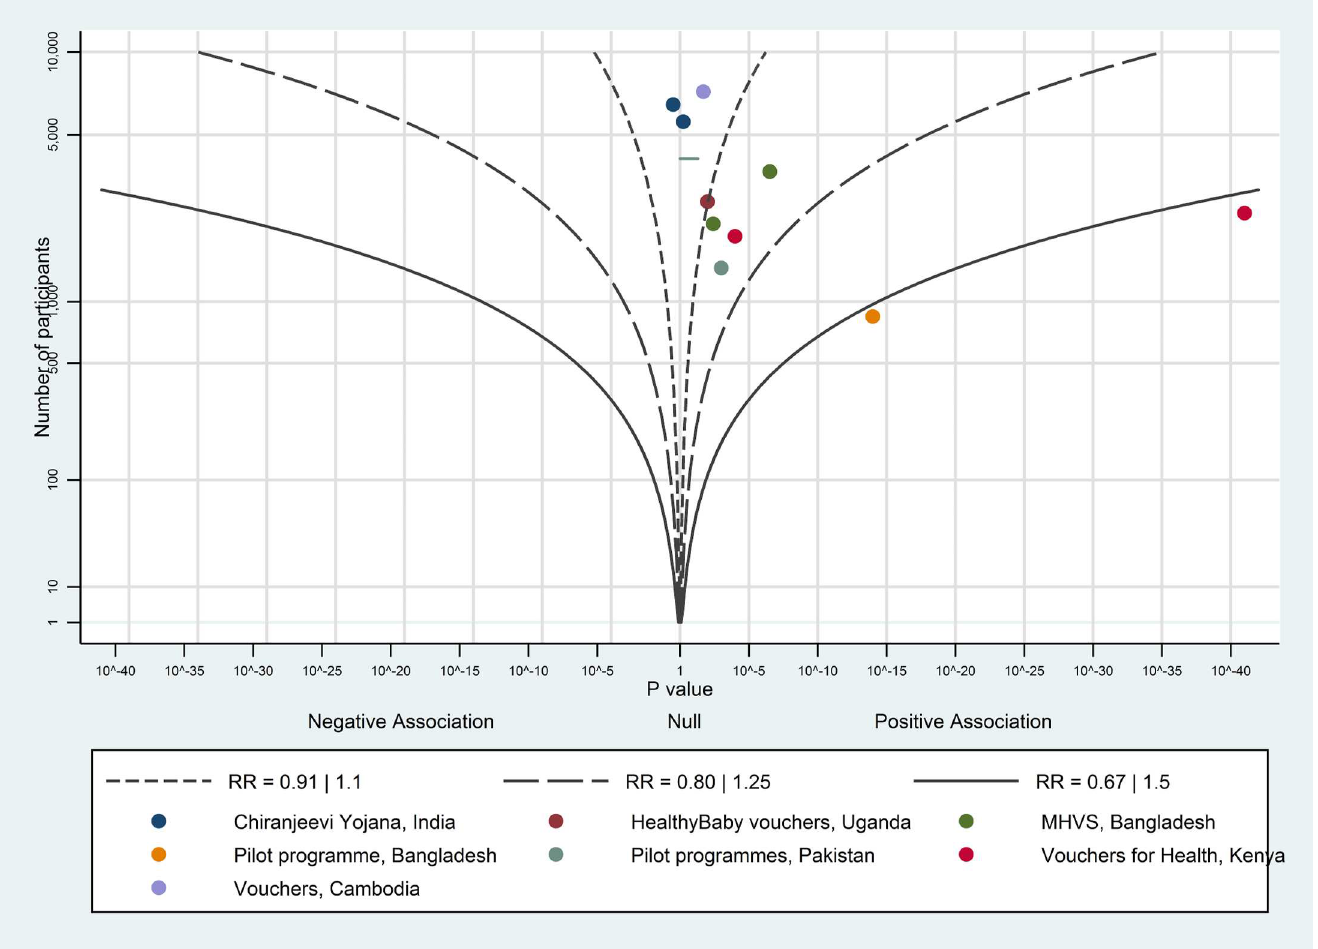
Fig 11. Albatross plot for effect of vouchers for maternity care serviceson births in a health facility. MHVS—Maternal Health Voucher